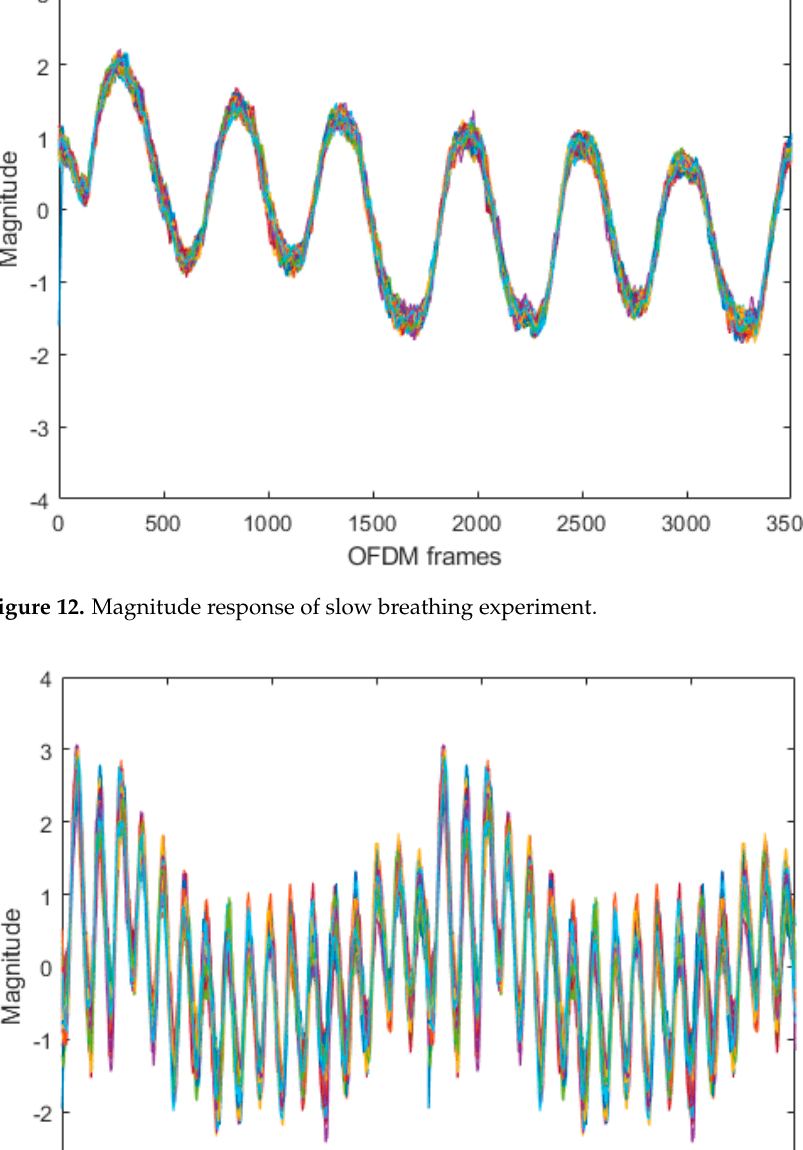
Figure 11. Magnitude response of normal breathing experiment.